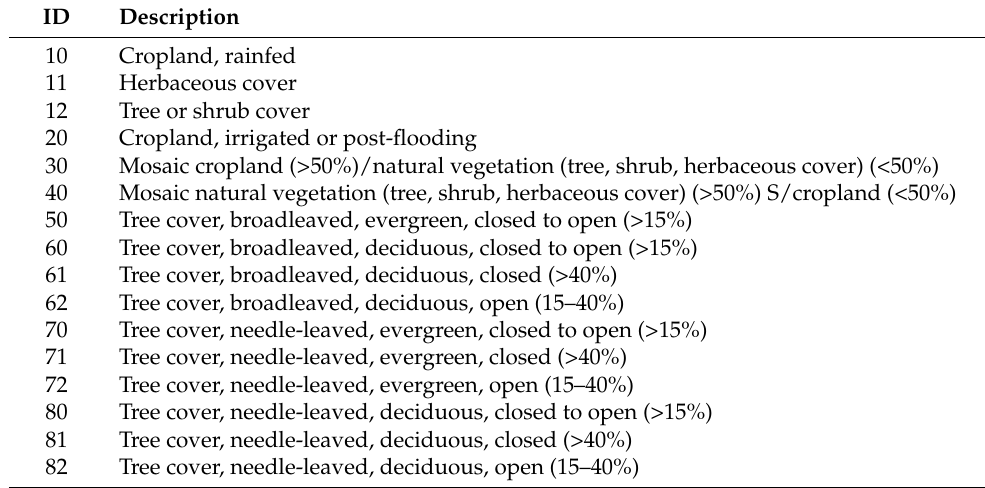
Table 1. CCI Landcover types’